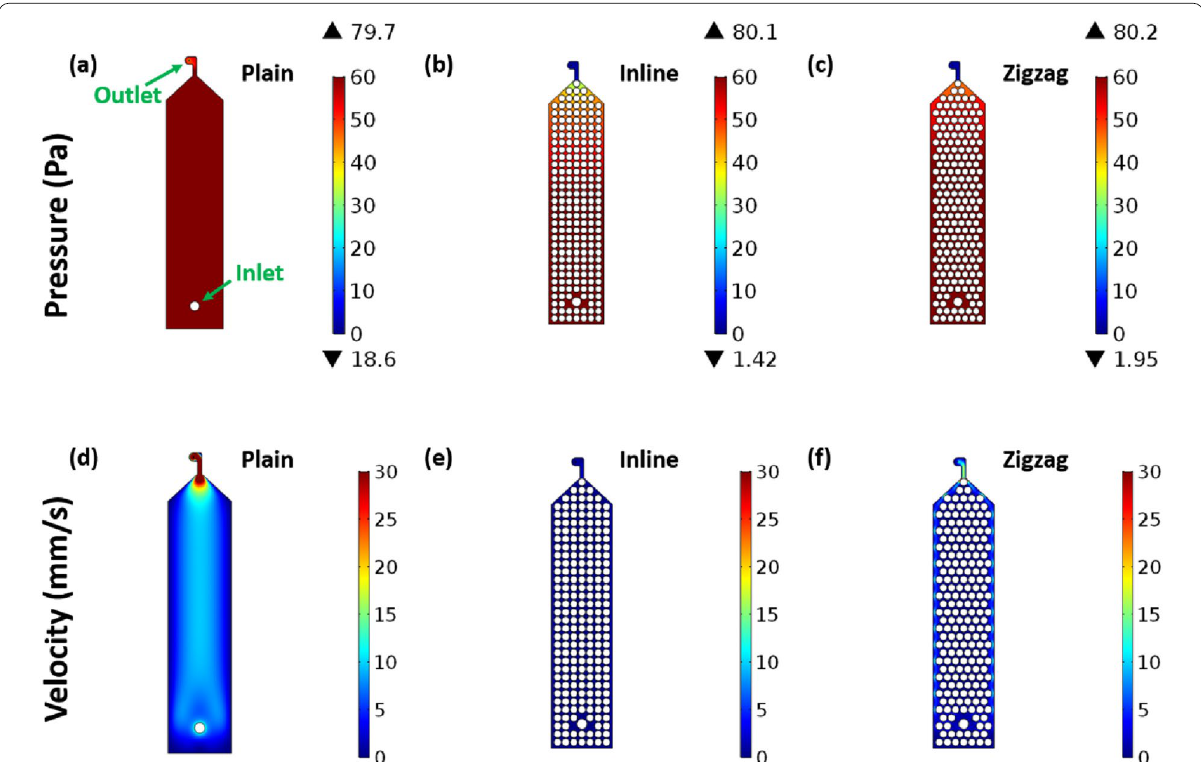
Fig. 3 Simulated results of the pressure and velocity of the fluid flow in the μFIC. a , d The pressure and velocity of the fluid flow in the microfluidic channel without inner structures. b , e ) The channel with crater‑shaped structures positioned inline and c , f the channel with crater‑shaped structures positioned in a zigzag